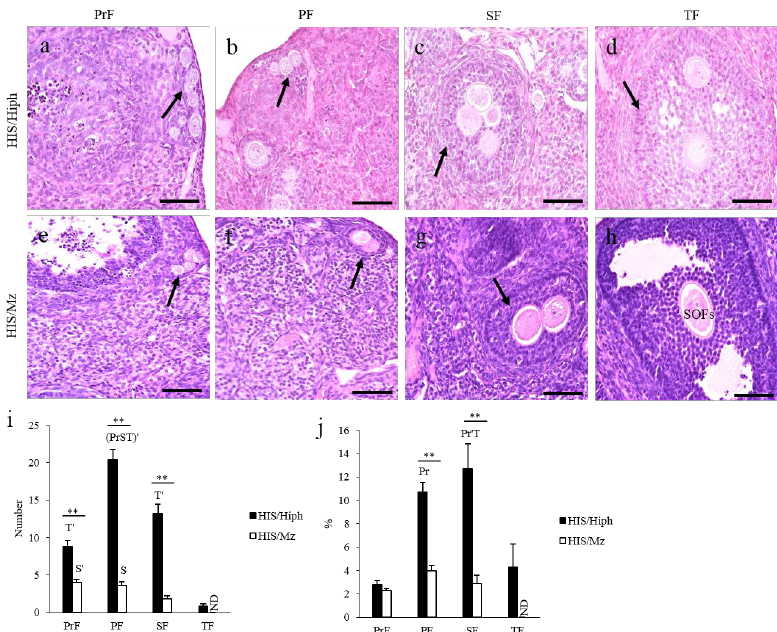
Figure 3. Multi-oocyte follicles (MOFs) in the ovaries of HIS/Hiph and HIS/Mz. ( a – h ) Histological observation of MOFs from hematoxylin–eosin-stained sections of the ovaries of 4-week-old HIS/Hiph ( a – d ) and HIS/Mz ( e – g ). MOFs denoted by the arrows are observed in follicle types classified as primordial follicle (PrF), primary follicle (PF), secondary follicle (SF), and tertiary (TF) follicle in HIS/Hiph ( a – d ) and PrF, PF, and SF in HIS/Mz ( e – g ). Panel h shows the TF-type single-oocyte follicle (SOF). Scale bars = 100 µm. (i , j) The total number and percentage of MOFs (follicular type MOFs/number of follicles in each type) classified as each follicle type in the ovary of HIS/Hiph and HIS/Mz. Values are the mean ± standard error. Asterisks indicate significant differences within follicle types between HIS/Hiph and HIS/Mz strains (Mann– Whitney U -test, ** p < 0.01). Pr, P, S, and T denote significant difference in the number of PrF, PF, SF, and TF, respectively, in HIS/Hiph and HIS/Mz (Kruskal–Wallis test followed by the Scheffé’s method, p < 0.05). Dashes beside letters indicate a highly significant difference ( p < 0.01). N = 5 in each strain. ND: Not detected.